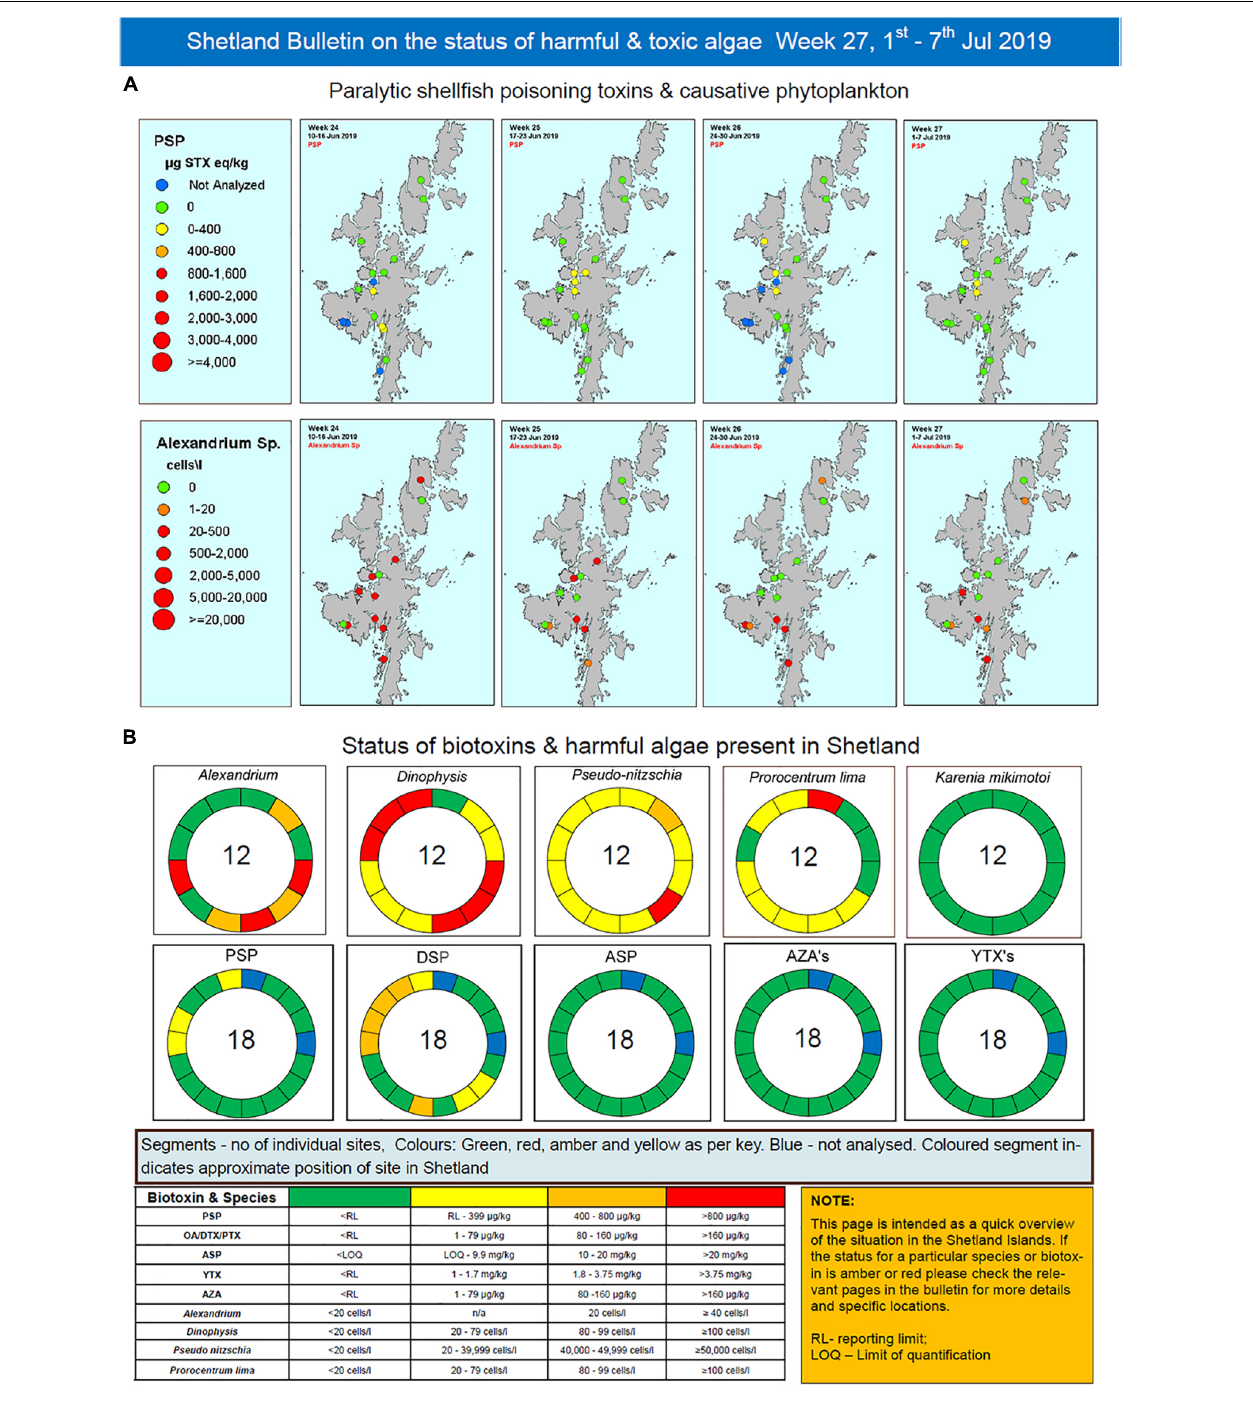
FIGURE 3 | Exemplar pages from the detailed Shetland Islands bulletin for the week of 1st of July 2019 representing (A) a map based view of paralytic shellfish toxins and their causative phytoplankton ( Alexandrium sp.) and (B) a schematic “donut” presentation of the Shetland Islands representing the locations and concentrations of the different species and toxins